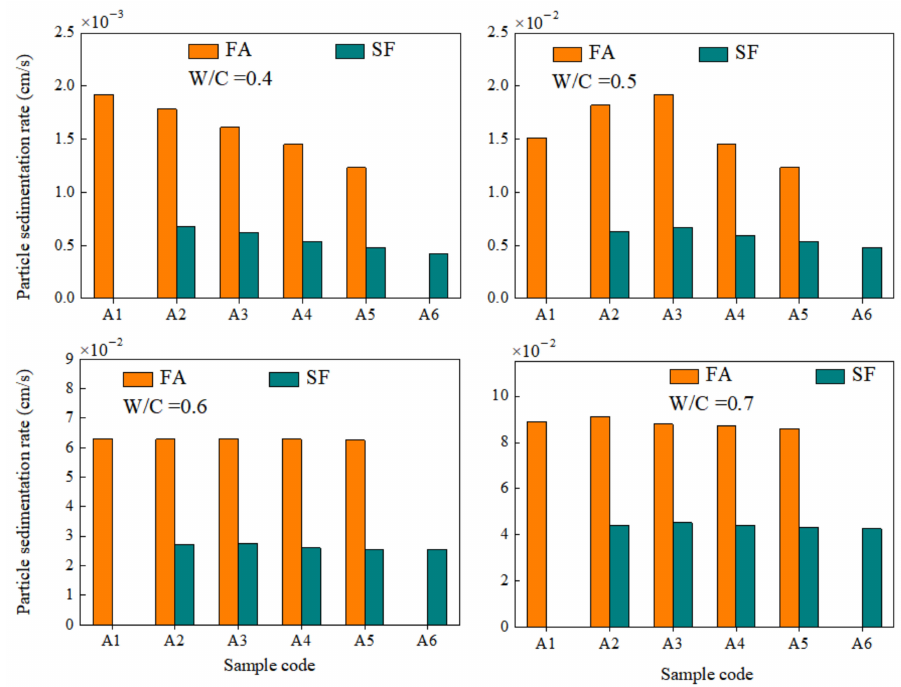
Figure 15. The sedimentation rate of SF and FA particles with different w/c